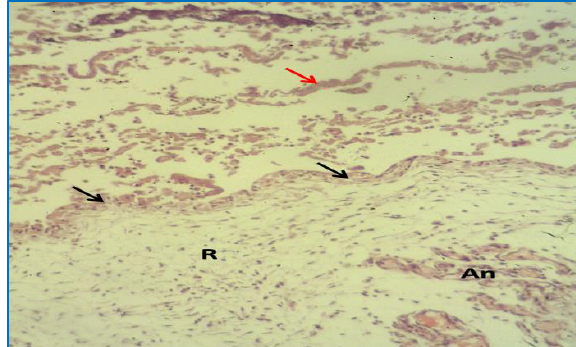
Figure, 6: Magnified section of skin (7 days post treatment with amniotic membrane) shows regeneration (R), newly formed blood vessels (An), line of thin inflammatory zone (black arrows) and fibrin thread (red arrow). H and E,